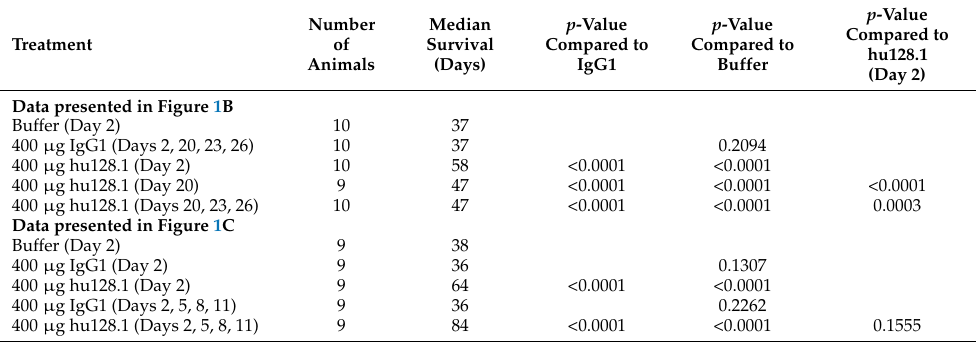
Table 1. Median survival and statistical analysis for the data in the local model of AIDS-NHL using 2F7-BR44